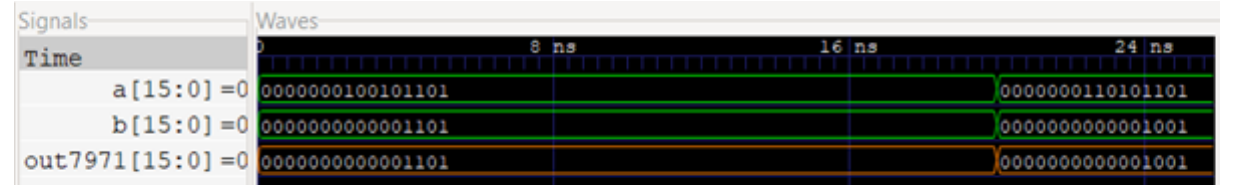
Figure 14. Circuit for the bitwise AND generated through Verilog.